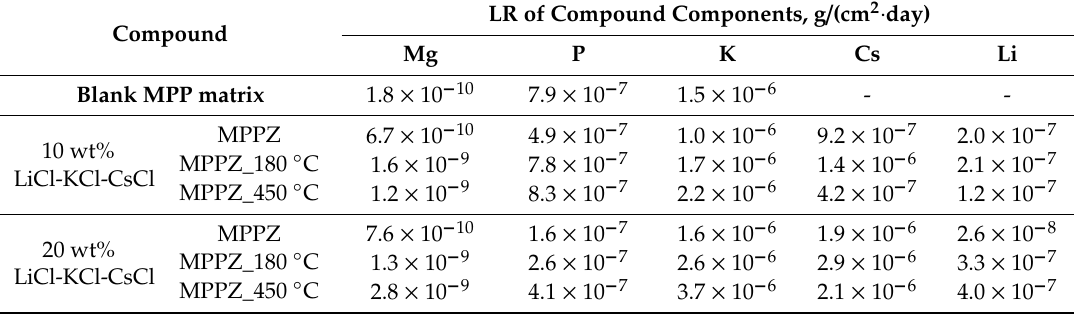
Table 3. Hydrolytic stability of the MPP compound samples containing LiCl-KCl-CsCl and zeolite in accordance with the PCT